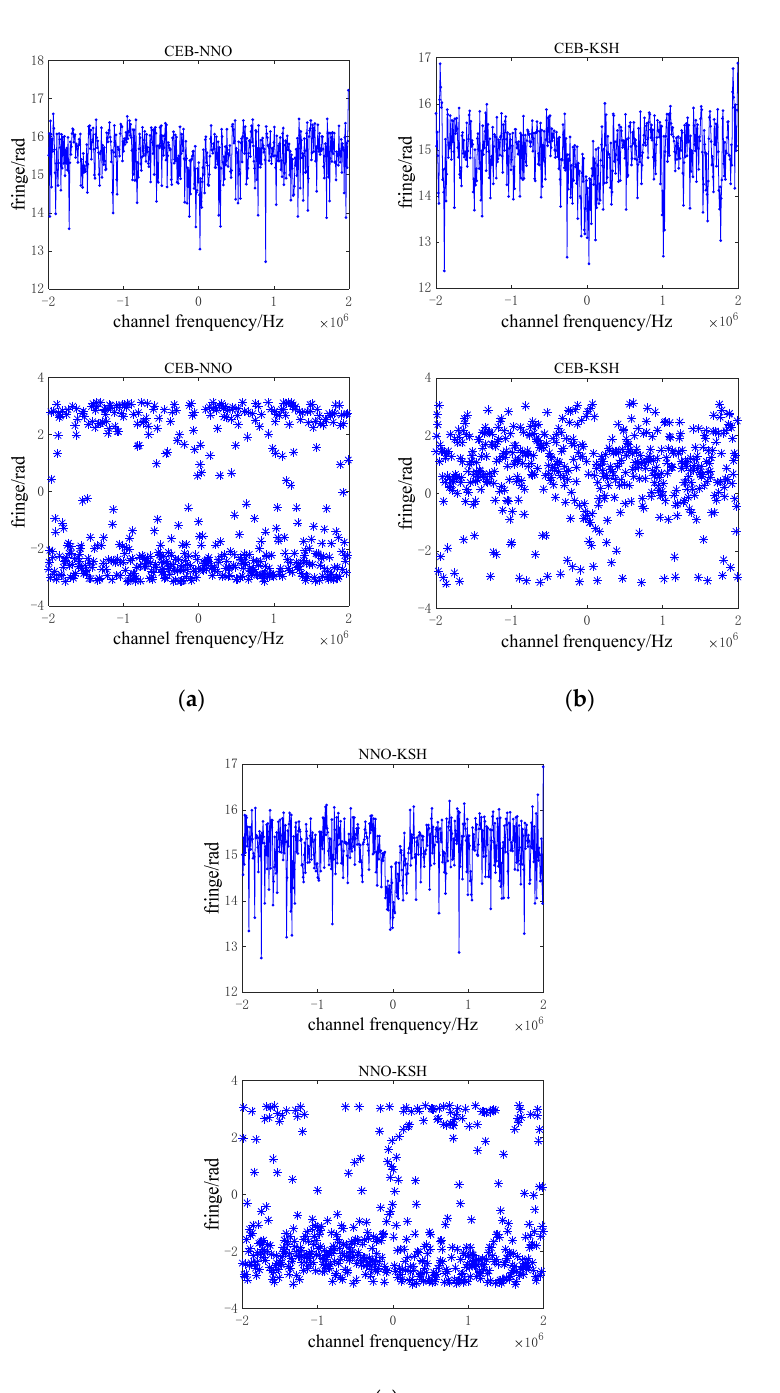
Figure 13. Interferometric fringe of quasar of all the baselines: ( a ) fringe of baseline CEB ‐ NNO—the SNR is about 22.1 dB; ( b ) fringe of Baseline CEB ‐ KSH—the SNR is about 11.9 dB; ( c ) Fringe of Baseline NNO ‐ KSH—the SNR is about 14.3 dB.